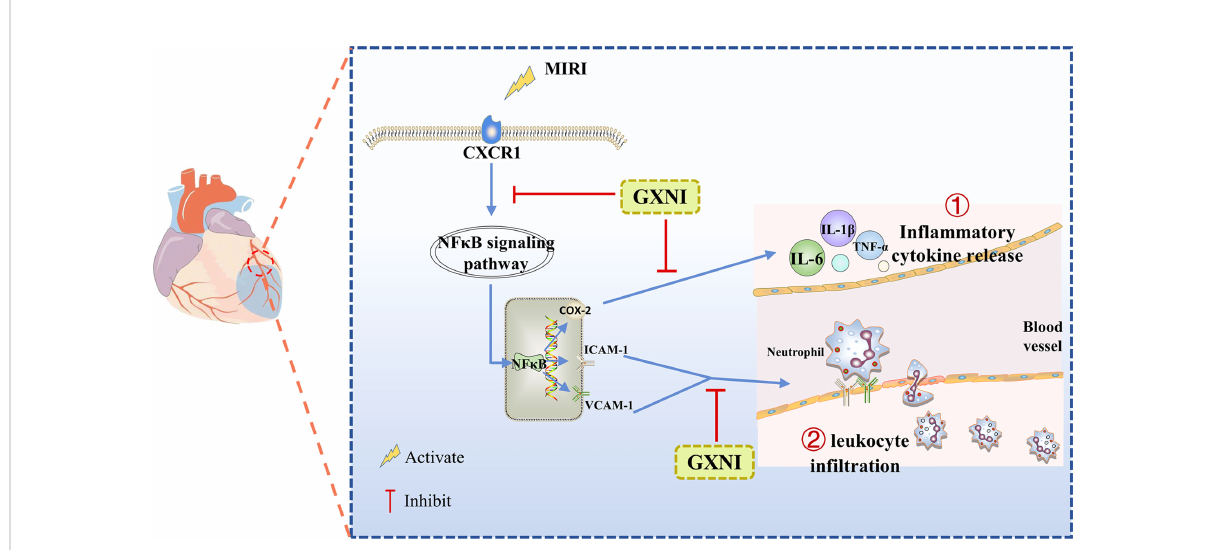
FIGURE 8 A schematic diagram of the mechanism of GXNI ameliorated myocardial injury in I/R mice via regulating the CXCR1-NF- k B-COX-2/ICAM-1/ VCAM-1 pathway to inhibit the release of in fl ammatory factors and leukocyte in fi